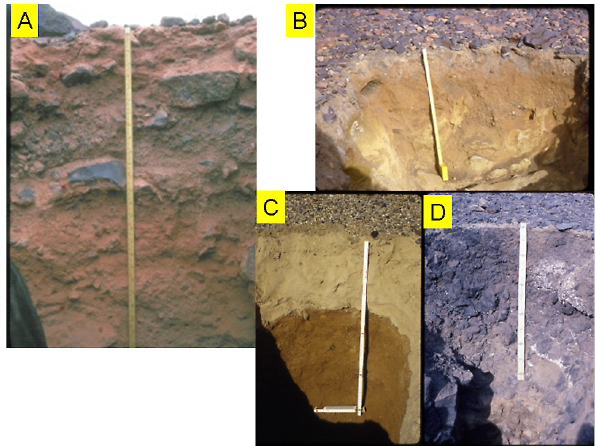
Fig. 2. Examples of buried soils in the Transantarctic Mountains: (A) this soil in upper Arena Valley shows multiple burials includ- ing scattered Taylor III boulders of 200ka age on the surface (not visible from image) over Taylor IV drift of early Pleistocene or late Pliocene age (the upper soil), which then buries Quartermain drift of Miocene age (notice the buried desert pavement including the intact ventifact on top of the buried Quartermain soil) (pedon 75–19); (B) a soil derived from early Pleistocene-aged drift containing pieces of formerly frozen Pliocene-aged drift in the Darwin Mountains (pe- don 78–33); (C) the 3.9Ma Hart ash burying a strongly developed soil from colluvium in central Wright Valley (pedon 87–29); (D) a lava flow burying an intensively developed soil in Taylor Valley containing abundant salts (pedon 84–05). K-Ar dating of lava flows can provide limiting ages of buried